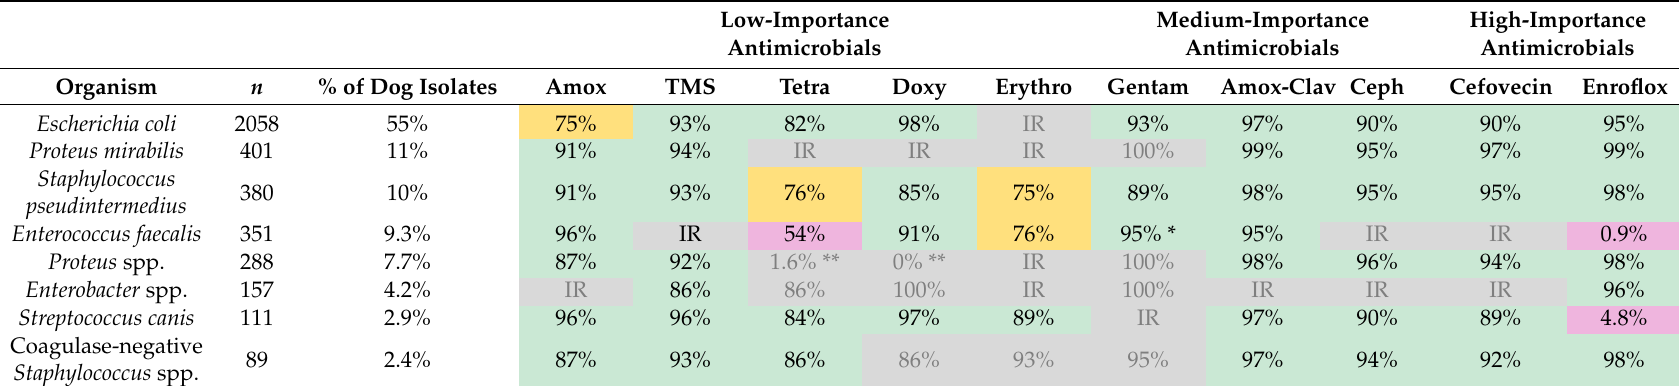
Coagulase-negative Staphylococcus